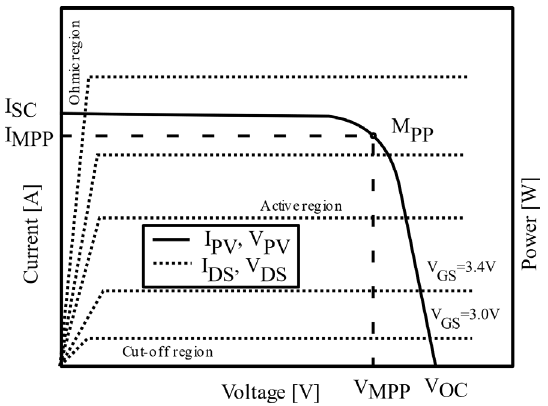
Figure 12. Characteristics of a PV module and a MOSFET. Source [39], own elaboration.